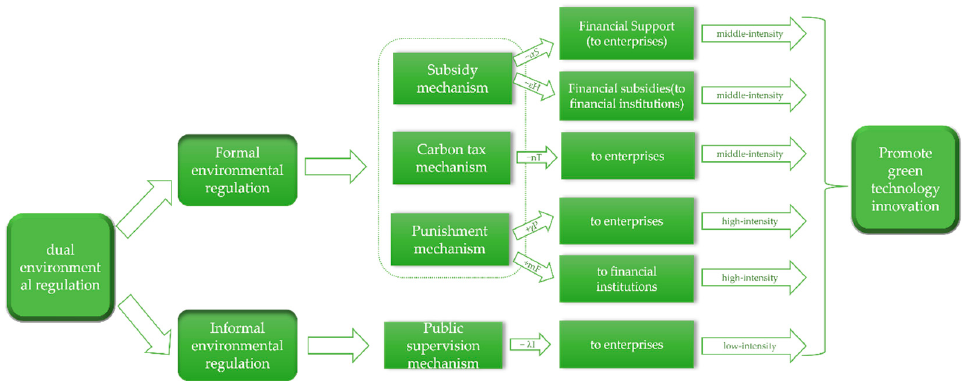
Figure 15. Dual environmental regulation that can promote the optimal implementation of green technology